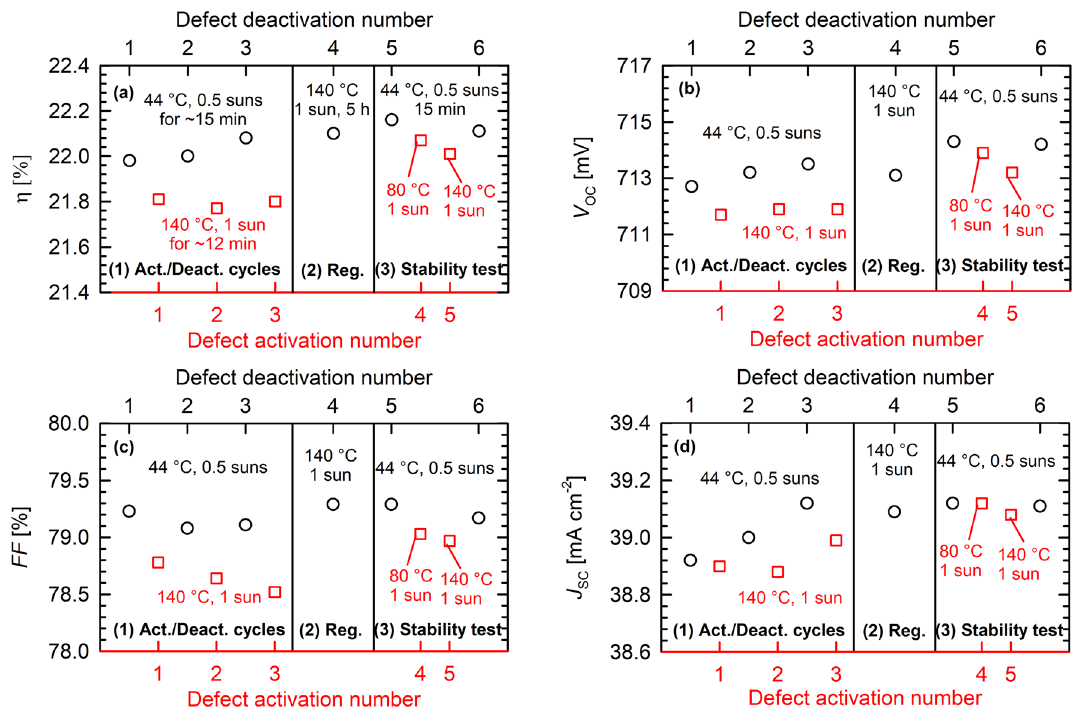
Figure 6. Reversibility of a Ga-doped Cz-Si POLO BJ solar cell through consecutive activation (140 °C, 1 sun, 12 min)/deactivation (44 °C, 0.5 suns, 15 min) cycles (1), regeneration through prolonged illumination at elevated temperatures (140 °C, 1 sun, 5 h) (2), and test of the stability of the regeneration at 80 and 140 °C (3). Shown are the measured cell parameters ( a ) energy conversion efficiency η, ( b ) open-circuit voltage V OC , ( c ) fill factor FF , and ( d ) short-circuit current density J SC